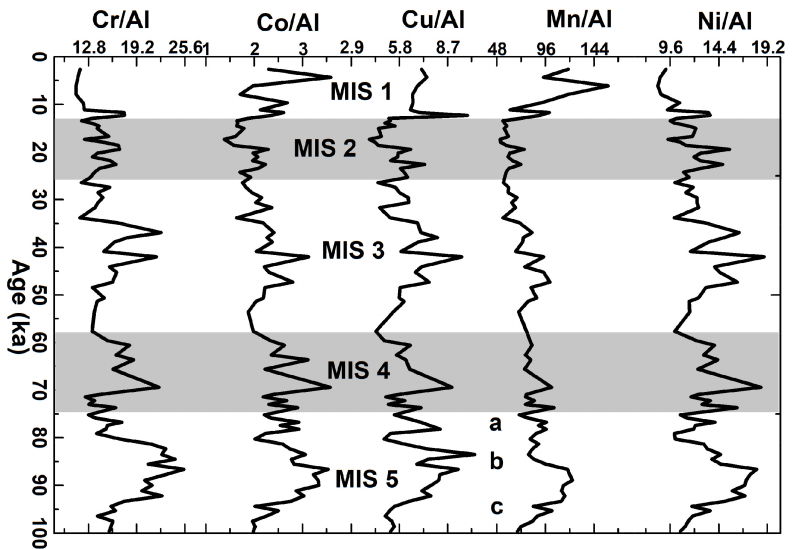
Figure 2. Down-core distribution of selected trace elements during the past 100 ka, in the sediment core SK117/GC08.